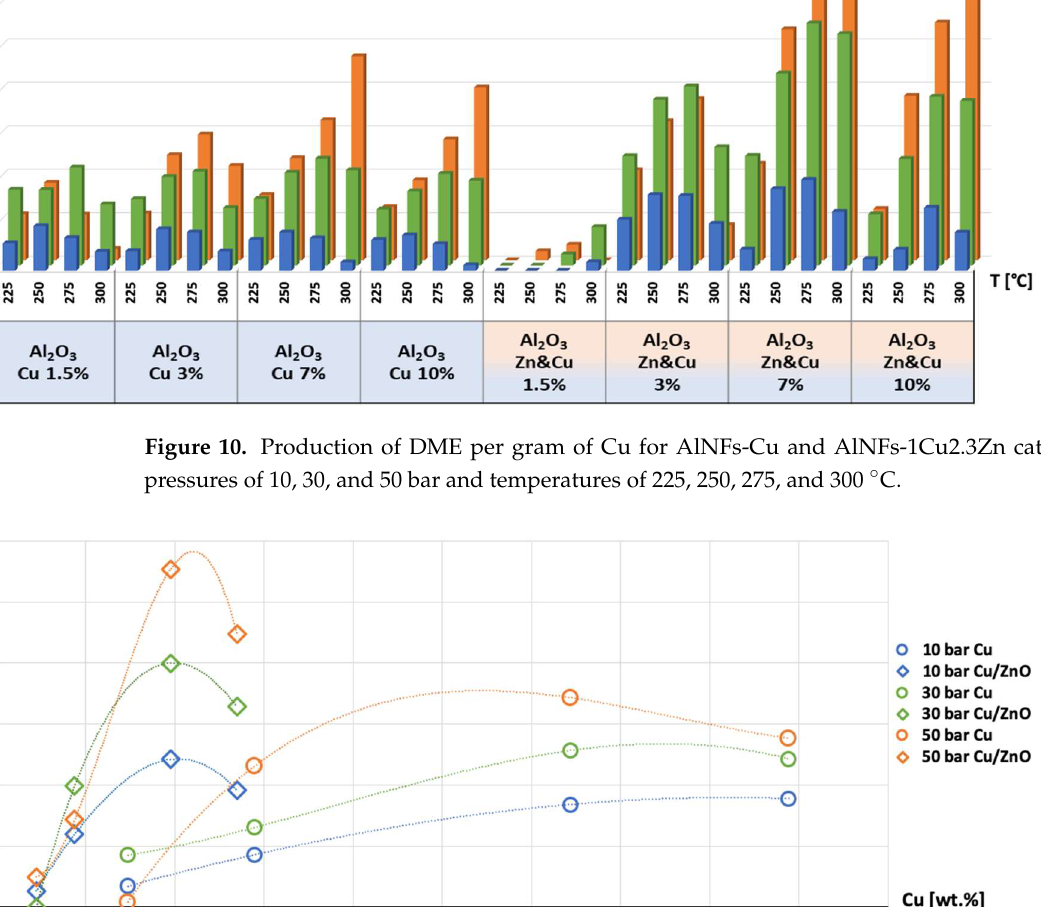
Figure 11. Production of methanol per gram of Cu as a function of Cu wt. % content in AlNFs-Cu (circle dots) and AlNFs-1Cu2.3Zn (rhombic dots) catalysts at pressures of 10 (blue), 30 (green), and 50 (orange) bar at temperature 300 °C.